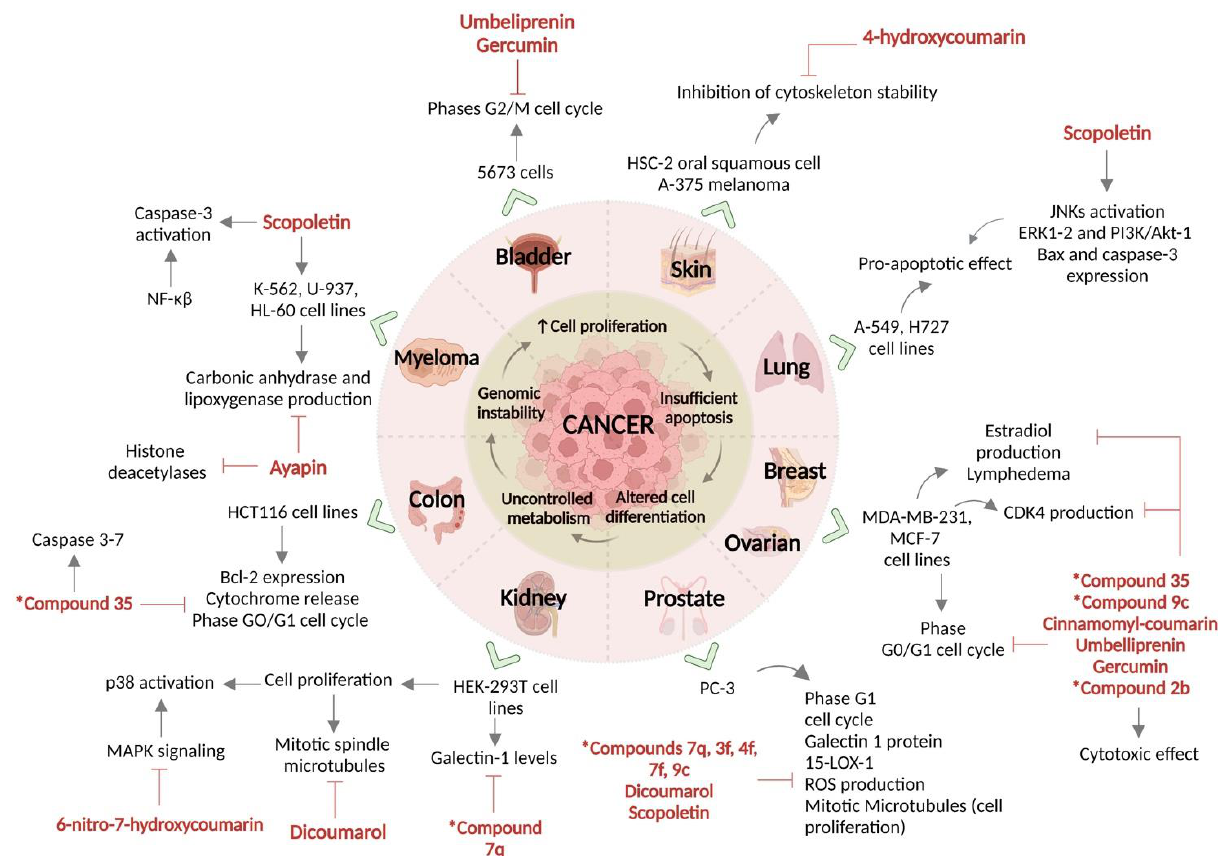
Figure 23. Coumarins as antineoplastic agents. Coumarins have been recently described as potent antineoplastic in different primary tumors as well as in metastatic ones. Coumarins exert a specific pro-apoptotic effect by the regulation of apoptotic pathways such as caspase, as well it has been seen as an important effect over hormonal-induced tumors such as breast and ovarium cancer, by regulating synthesis and signaling of hormones such as estradiol. *Compounds: 35 = 2-(4-(2-(tert- butoxy)-2,3-dimethyl-4-oxo-8-(quinolin-3-yl)-2,3-dihydrochromeno[3,4- d ] imidazol-1 490 (4 H )-yl) phenyl)-2-methylpropanenitrile; 7q = Ethyl 1-((7-((4-nitrobenzyl) oxy)-2-oxo-2 H -chromen-4-yl) me- thyl) piperidine-4-carboxylate; 3f = 3-farnesyloxycoumarin; 4f = 4-farnesyloxycoumarin; 7f = 7-far- nesyloxycoumarin; 9c = 7-(Diethylamino)- N -(4-methoxyphenyl)-2-oxo-2 H -chromene-3-sulfona-